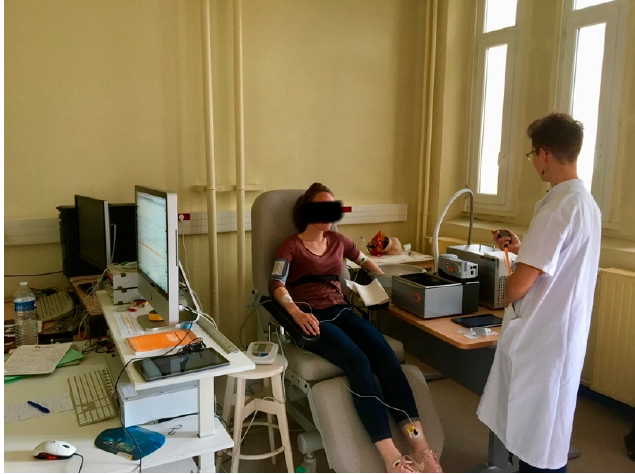
Figure 3. Clinical trial set-up during a CPT test.